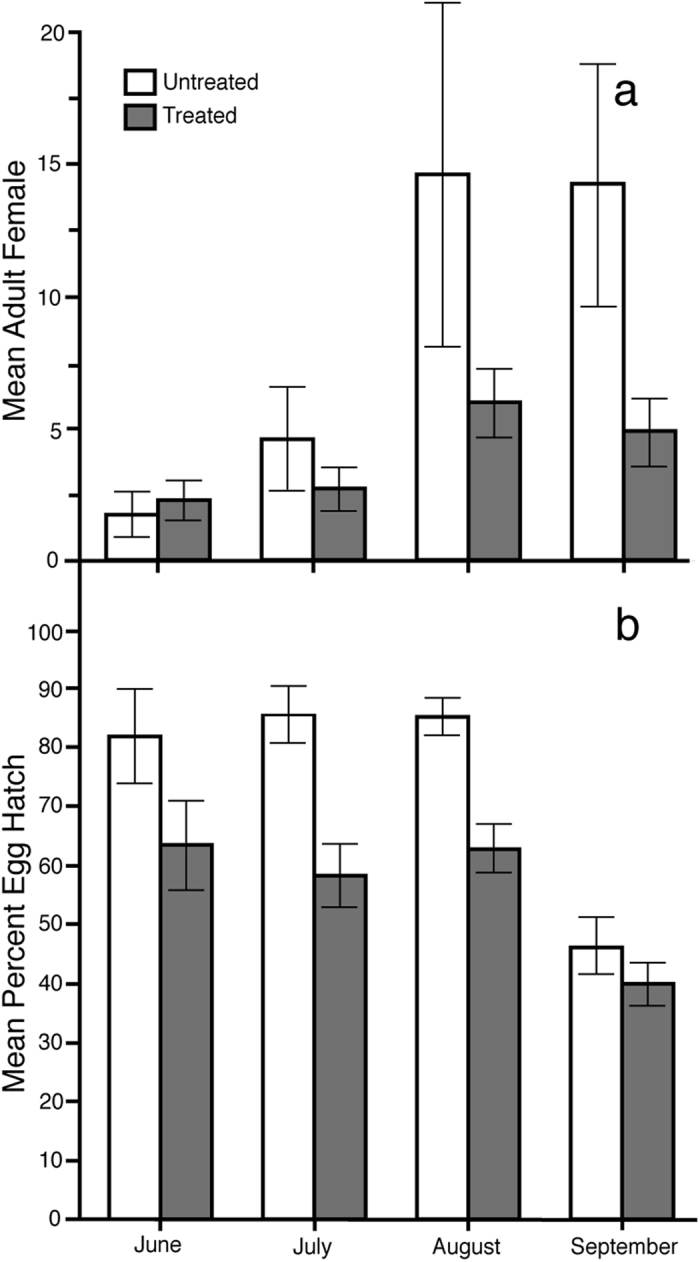
Mean (a) number of female adult Ae. albopictus collected using BG traps and (b) percent hatch of Ae. albopictus eggs collected using oviposition traps at the Treated and Untreated sites in the 2014 field season. In 2014, incompatible males were introduced at the Treated site only. Bars show 95% confidence intervals.